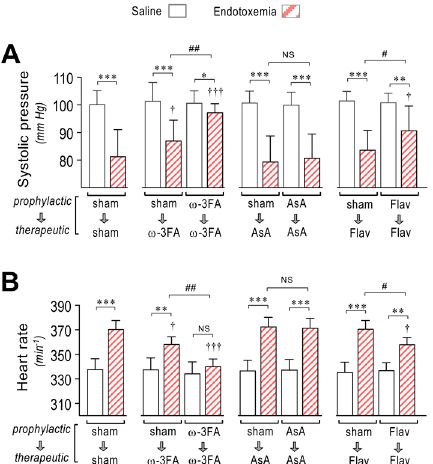
Figure 6. Effects in systolic blood pressure and cardiac frequency through dietary supplementation based on ω -3 FA, ascorbic acid, or polyphenolic antioxidant flavonoids in endotoxemic rats. After saline (open bars) and endotoxemia (dashed bars) treatments that were supplemented with water (sham), ω -3 fatty acid ( ω -3 FA), ascorbic acid (AsA), or polyphenolic antioxidant flavonoids (Flav), through a therapeutic and a prophylactic protocol, the systolic blood pressure ( A ) and cardiac frequency ( B ) were determined. Statistical differences were assessed by two-way ANOVA followed by Dunnett’s post hoc test. * p < 0.05; ** p < 0.01; *** p < 0.001 comparing saline and endotoxemia condition. † p < 0.05, ††† p < 0.001 compared with sham-treated condition. # p < 0.05; ## p < 0.01 comparing non-survivor endotoxic condition between therapeutic and prophylactic protocol. NS: non-significant. Results are expressed as the mean ± SD ( N = 12).